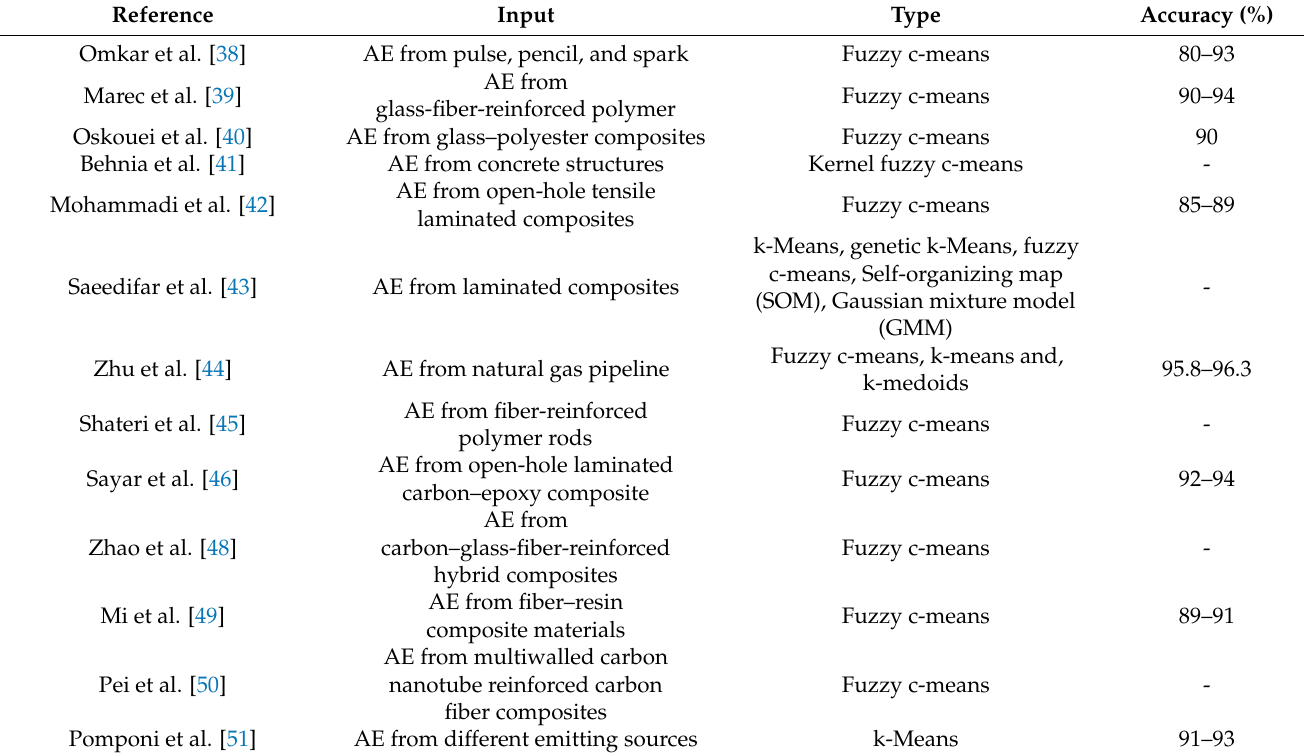
Table 1. Clustering methods for AE